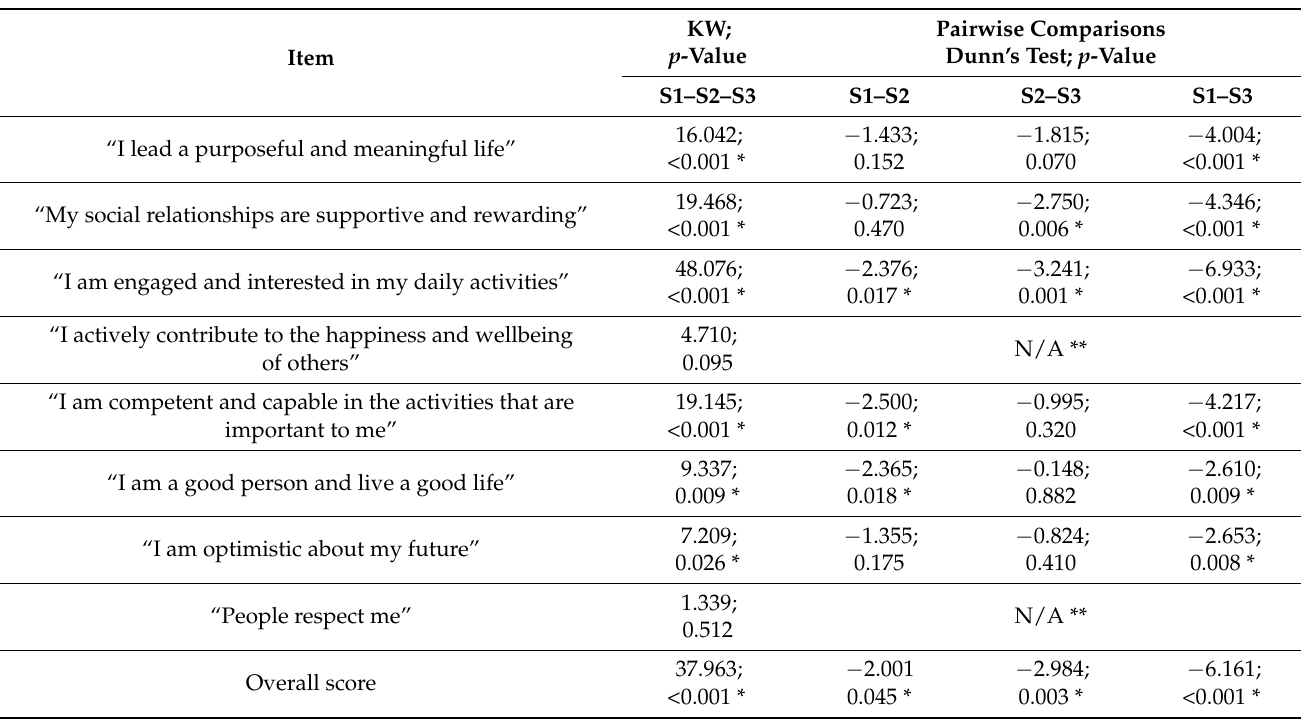
Table 5. Results of the FS.